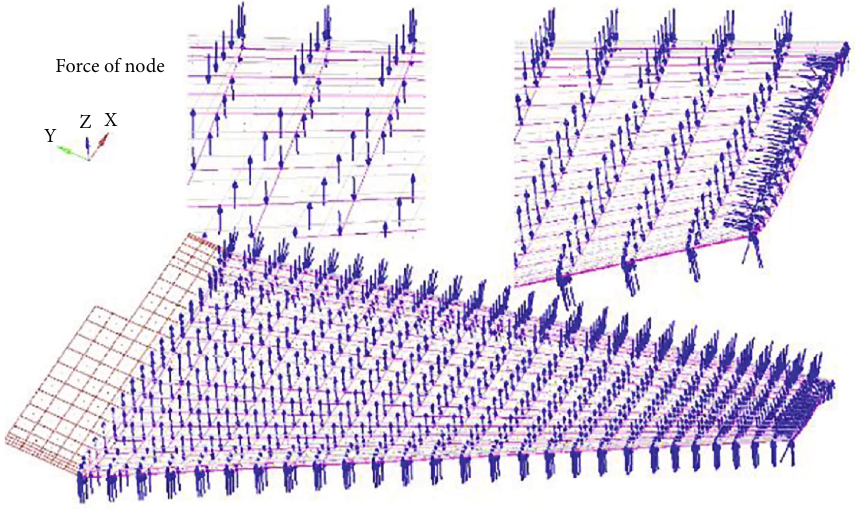
Figure 8: The force vectors of aerodynamic load interpolated to the structural nodes.